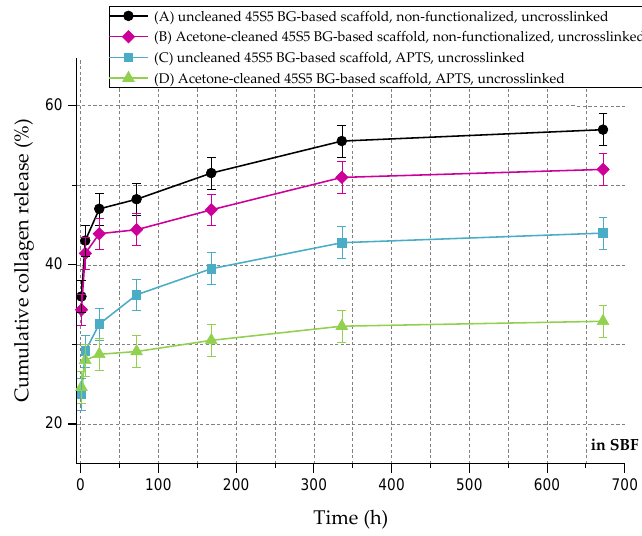
Figure 11. Cumulative collagen release from different types of 45S5 BG-based scaffolds in SBF.